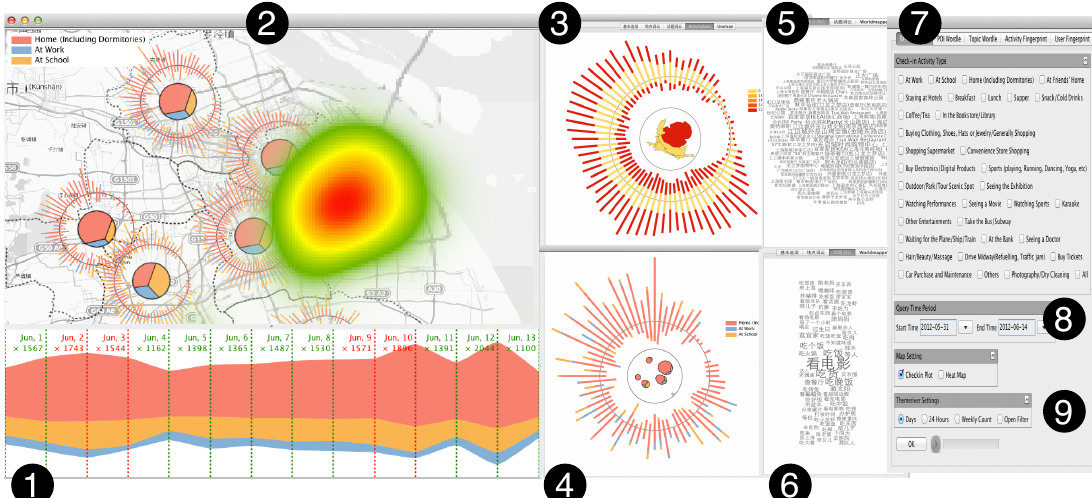
Figure 5. The figure shows two week’s dinning behavior extracted from Sina Weibo (Microblog) check-in dataset in Shanghai. Our system Sci-Fin compressed the whole city’s check-in records related to dinning in real time. In this figure, regions’ fingerprints are placed on map to show their spatio-temporal evolution. The activity fingerprint uses the space distortion inside to represent the records’ geographic distribution. The user fingerprint shows the top 50 users’ spatio-temporal patterns. The numbered annotations from 1 to 9 correspond to major design components and functionality which is described in details in the paper. We developed an interaction “Hightlight” (details can be found in Section 4.3) illustrating all the raw messages that a focused user or users posted during all the activities s/he or they are involved in. And two message views (5 and 6) are proposed to summarize the high frequency keywords extracted from these messages in a Wordle display, showing the overall distribution of the places they uploading records (POI View, 5) and content overview of the messages they posted.